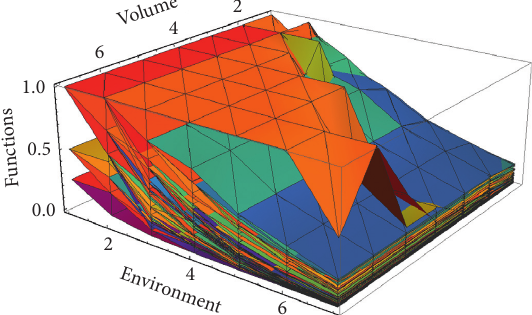
Figure 7: Fraction of the number of environment configurations that induce different functions on the volumes for environment thicknesses and volume sizes form 1 to 7. Note that under some rules, each environment induces a unique function for all volume sizes from 1 to 7.